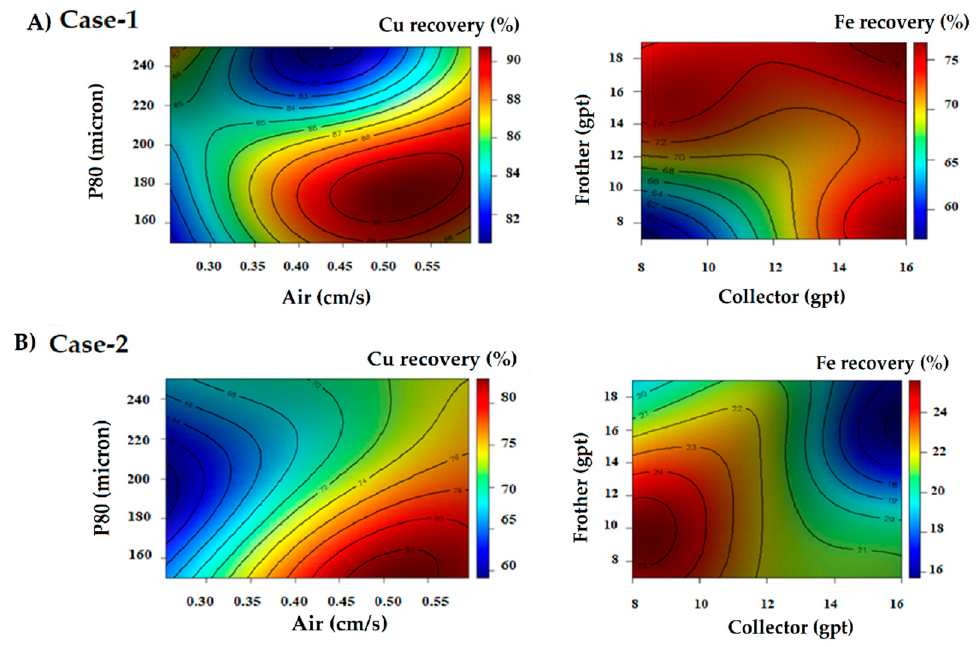
Figure 5. Response surface contours for copper and iron recoveries.